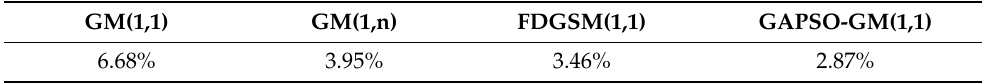
Table 6. MAPE of the test set using the four